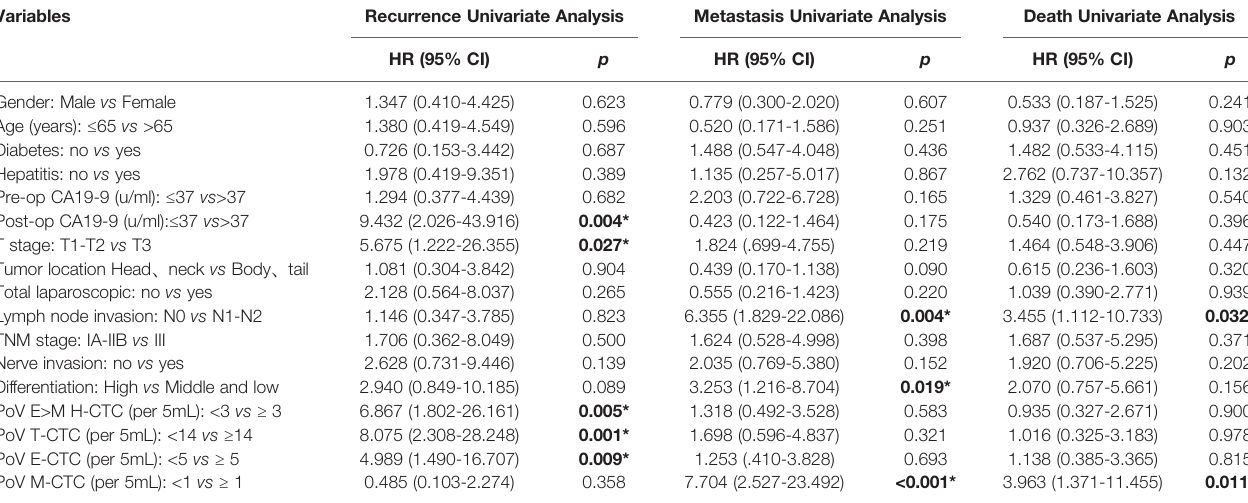
TABLE 3 | Univariate Cox regression analysis for postoperative progression.